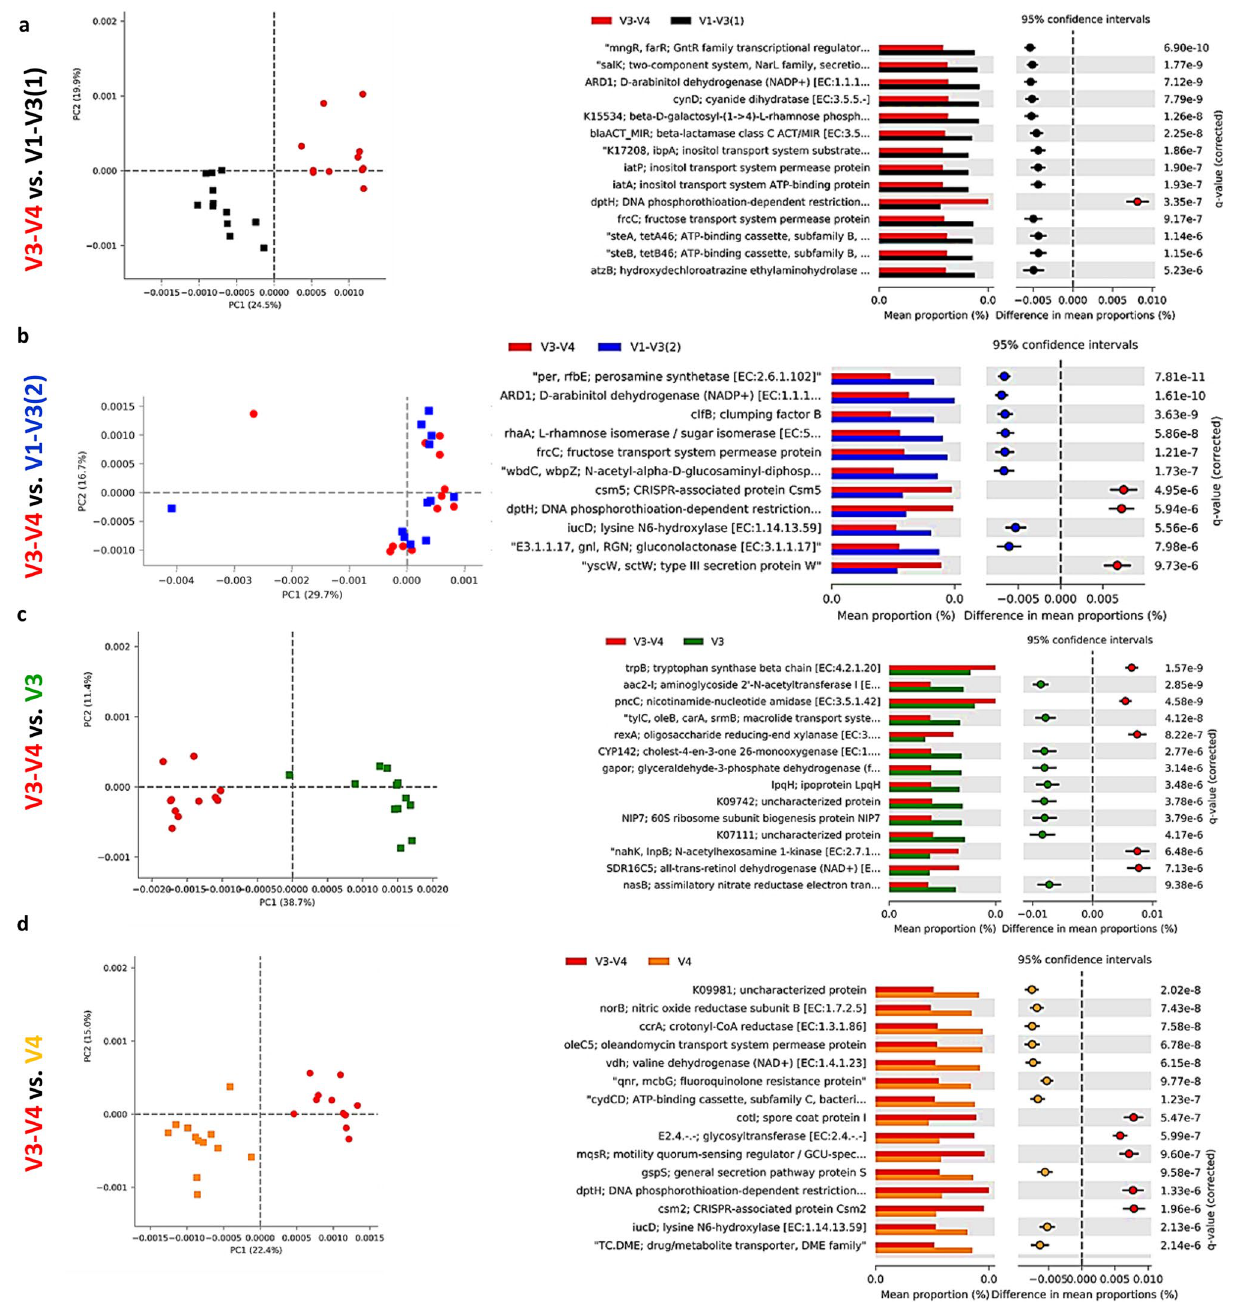
Figure 7. Effect of the primer set on predicted function of the cecal microbiota in chickens. Function of the microbiota was determined using PICRUST with KEGG database and visualized using STAMP. Principal component analysis (PCA) and extended error bar plots for comparison of predicted function of microbiota between (a) V3–V4 and V1–V3(1) (b) V3–V4 and V1–V3(2), (c) V3–V4 and V3, (d) V3–V4 and V4, (e)